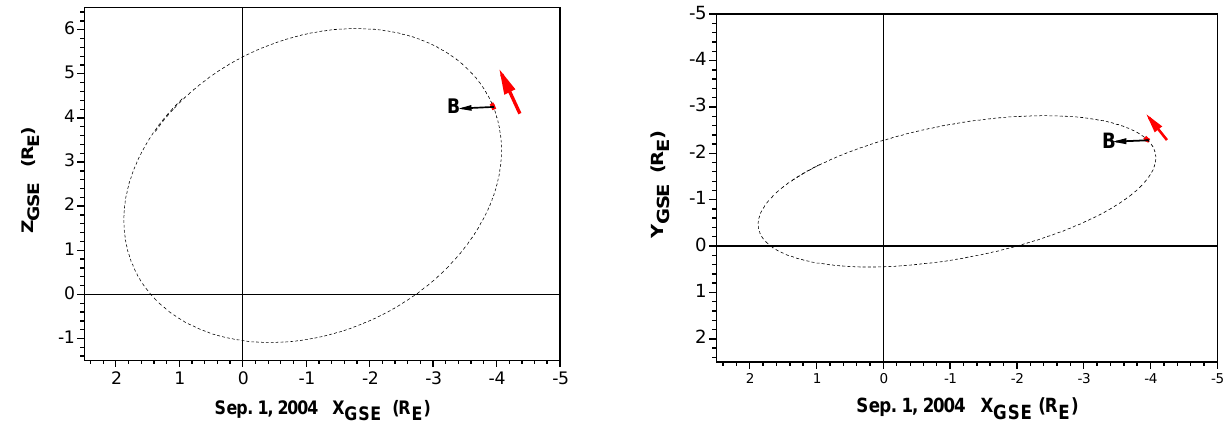
Fig. 2. The location of TC-2 in the X-Y plane (right), and in the X-Z plane (left) in the GSE system. Black arrows indicate the magnetic field direction and red arrows the direction of motion of the spacecraft at the time of the PADs shown in Fig. 1.